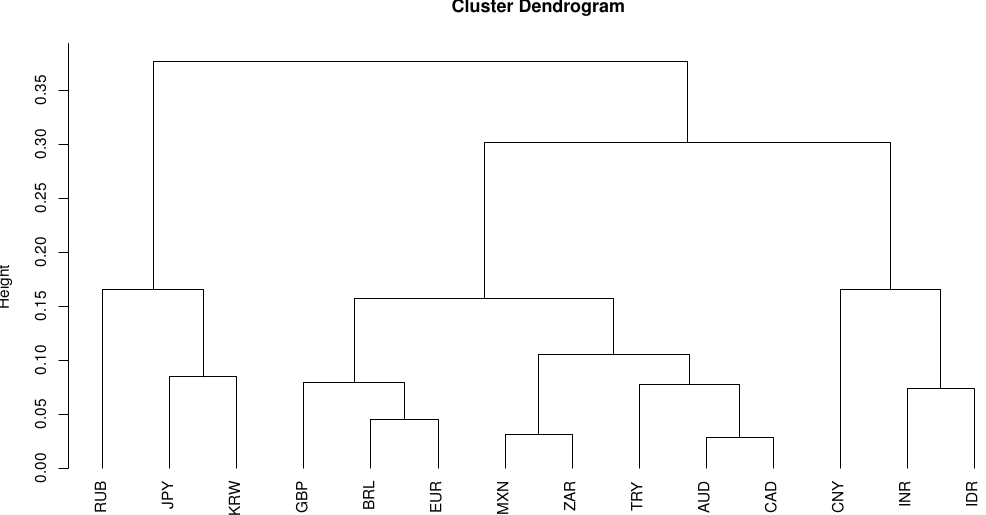
Figure 10. The dendrogram of the clustering procedure based on WNACut methods with affinity matrix as WLTMDs for k =